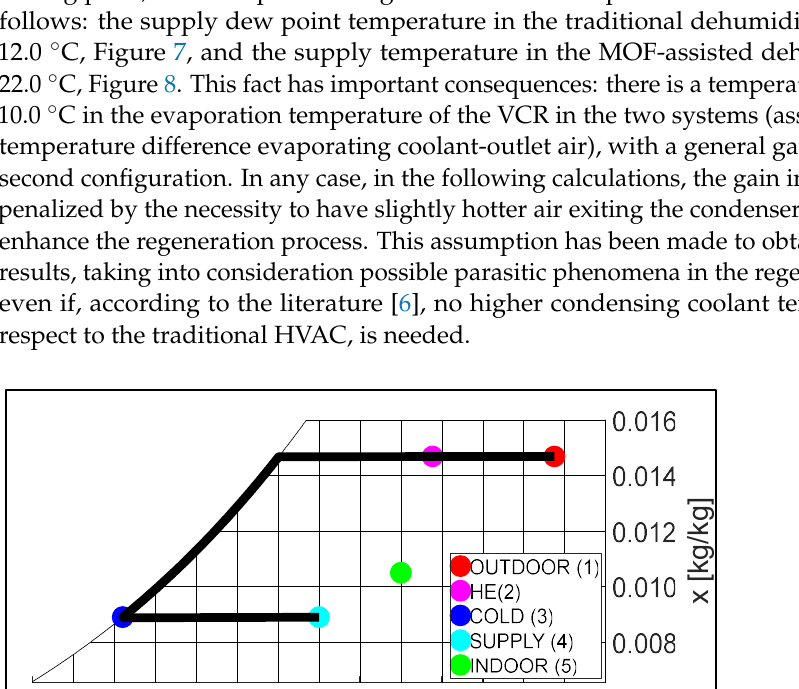
Figure 8. Transformations for HVAC with MOF-assisted dehumidification (case B, scenario 1). 5.2. Comparison between Traditional and MOF-Assisted Dehumidification It is possible to compare the different configurations in terms of cooling power pro- vided by the cooling coil, consequently in terms of electrical power consumption of the VCR (Table 4). The cooling power required in the different scenarios is always the same for the HVAC with traditional dehumidification, because the cooling coil must cool down the inlet air to the dew point temperature of the supply air. In the last column, the savings compared to the traditional configuration are reported. Table 4. Cooling power and electric power consumption for the two HVAC configurations. CASE